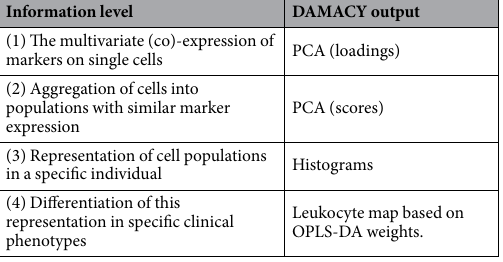
Table 2. The four information levels of multidimensional flow cytometric